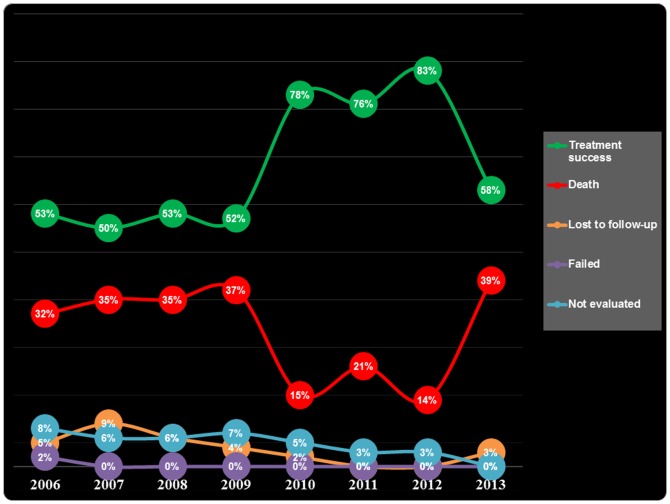
Trend of TB treatment outcomes by year in TB/HIV co-infected patients from 2006 to 2013.